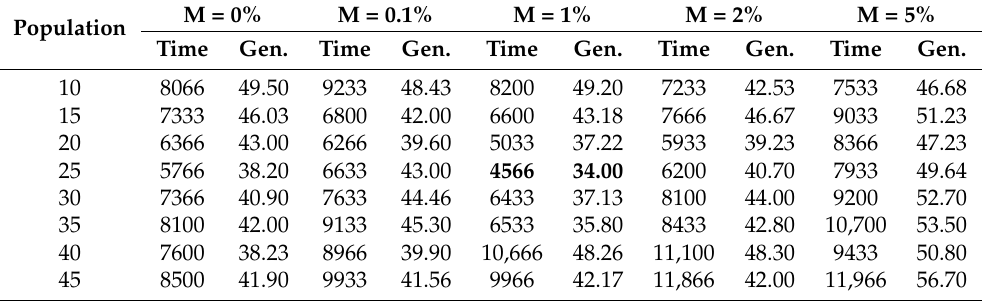
Table 2. Results of different population sizes and mutation rates. M is the mutation rate, Gen. the number of generations. Elitism maintained in 5.